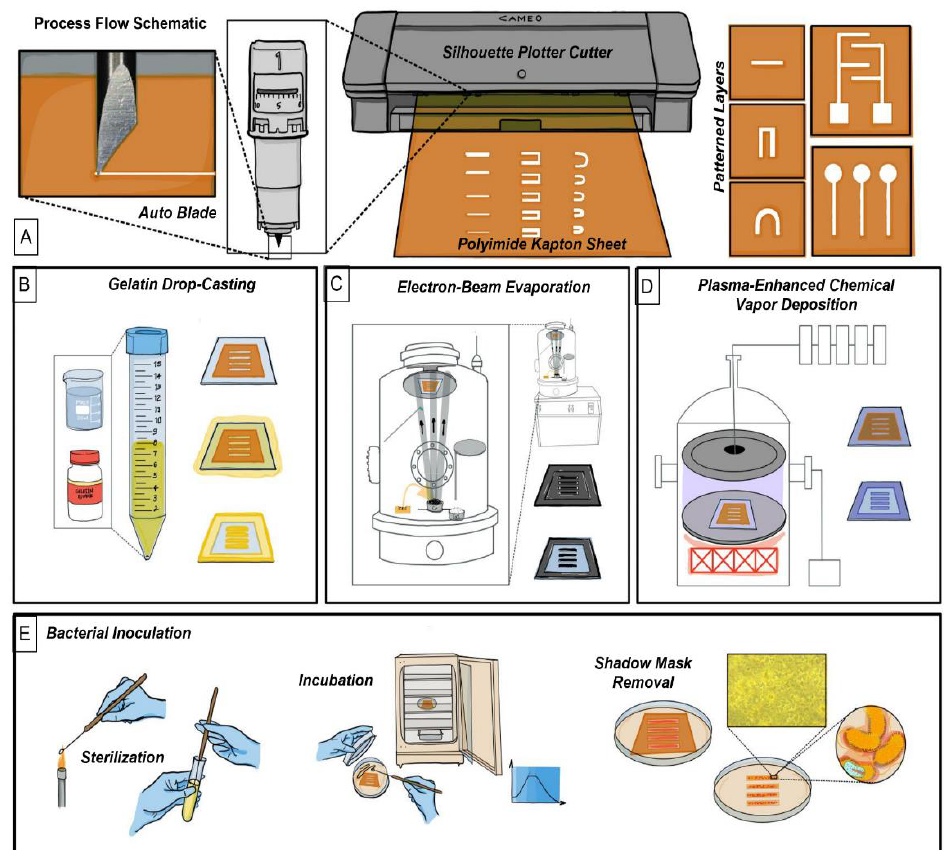
Figure 1. Process flow schematic: ( A ) Silhouette Plotter Cutter along with fabricated designs that were evaluated in this study (right). ( B ) Schematic of the casting process for 10 wt% gelatin. ( C ) E-beam evaporation process. ( D ) Plasma Enhanced Chemical Vapor Deposition (PECVD) process for the deposition of SiO 2 . ( E ) Culturing of E. coli K-12 & X. alfalfae .